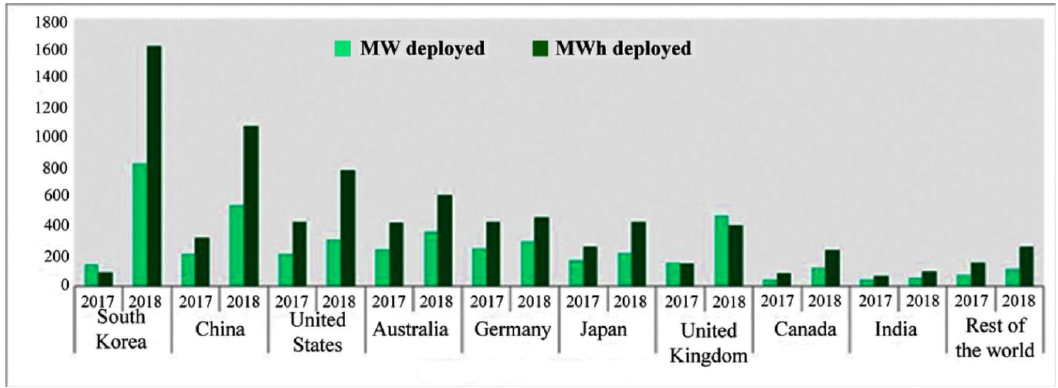
Figure 80. Global energy storage capacity in 2017 and 2018, which shows a significant rise in 2018 compared to 2017 both in terms of power and energy units [236].